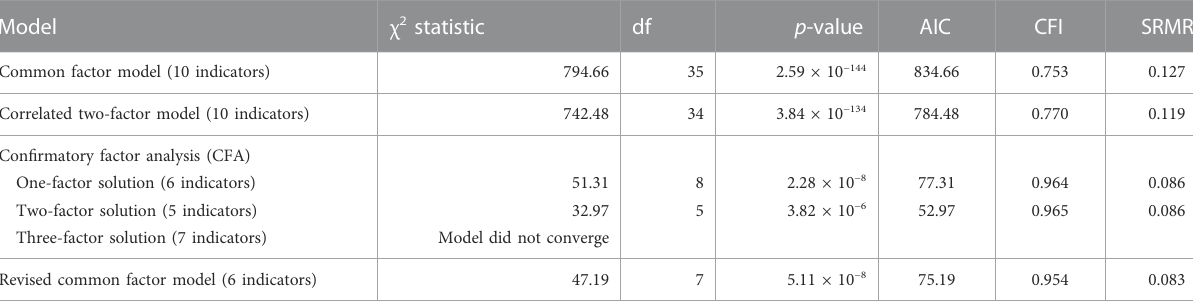
Figure 1B). The strongest correlations were